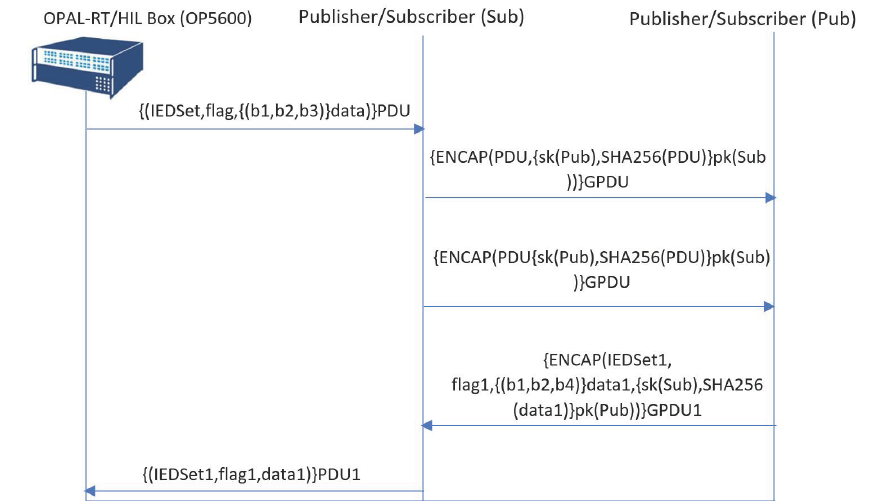
Figure 7. SPDL flow of the GOOSE protocol with IEC 62351.